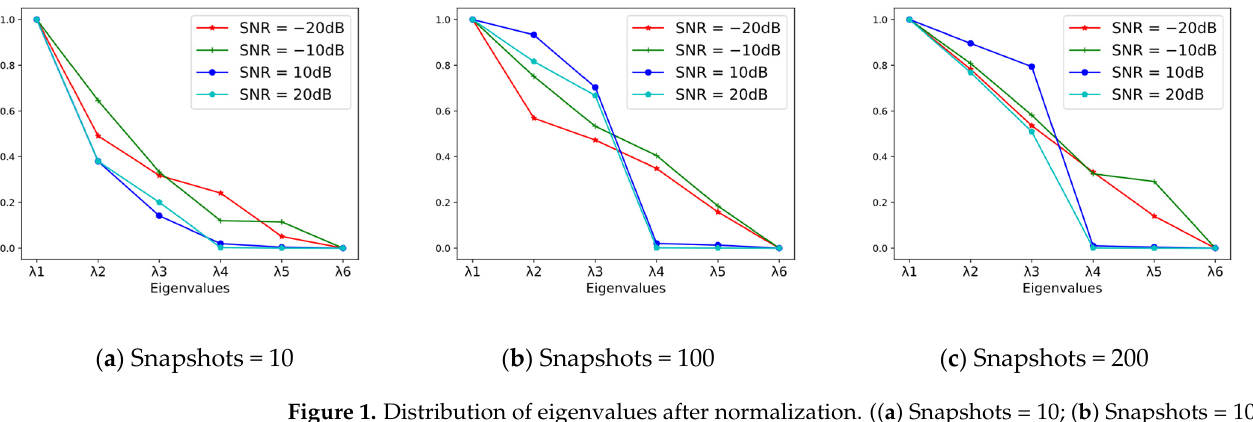
Figure 1. Distribution of eigenvalues after normalization. (( a ) Snapshots = 10; ( b ) Snapshots = 100; ( c ) Snapshots =